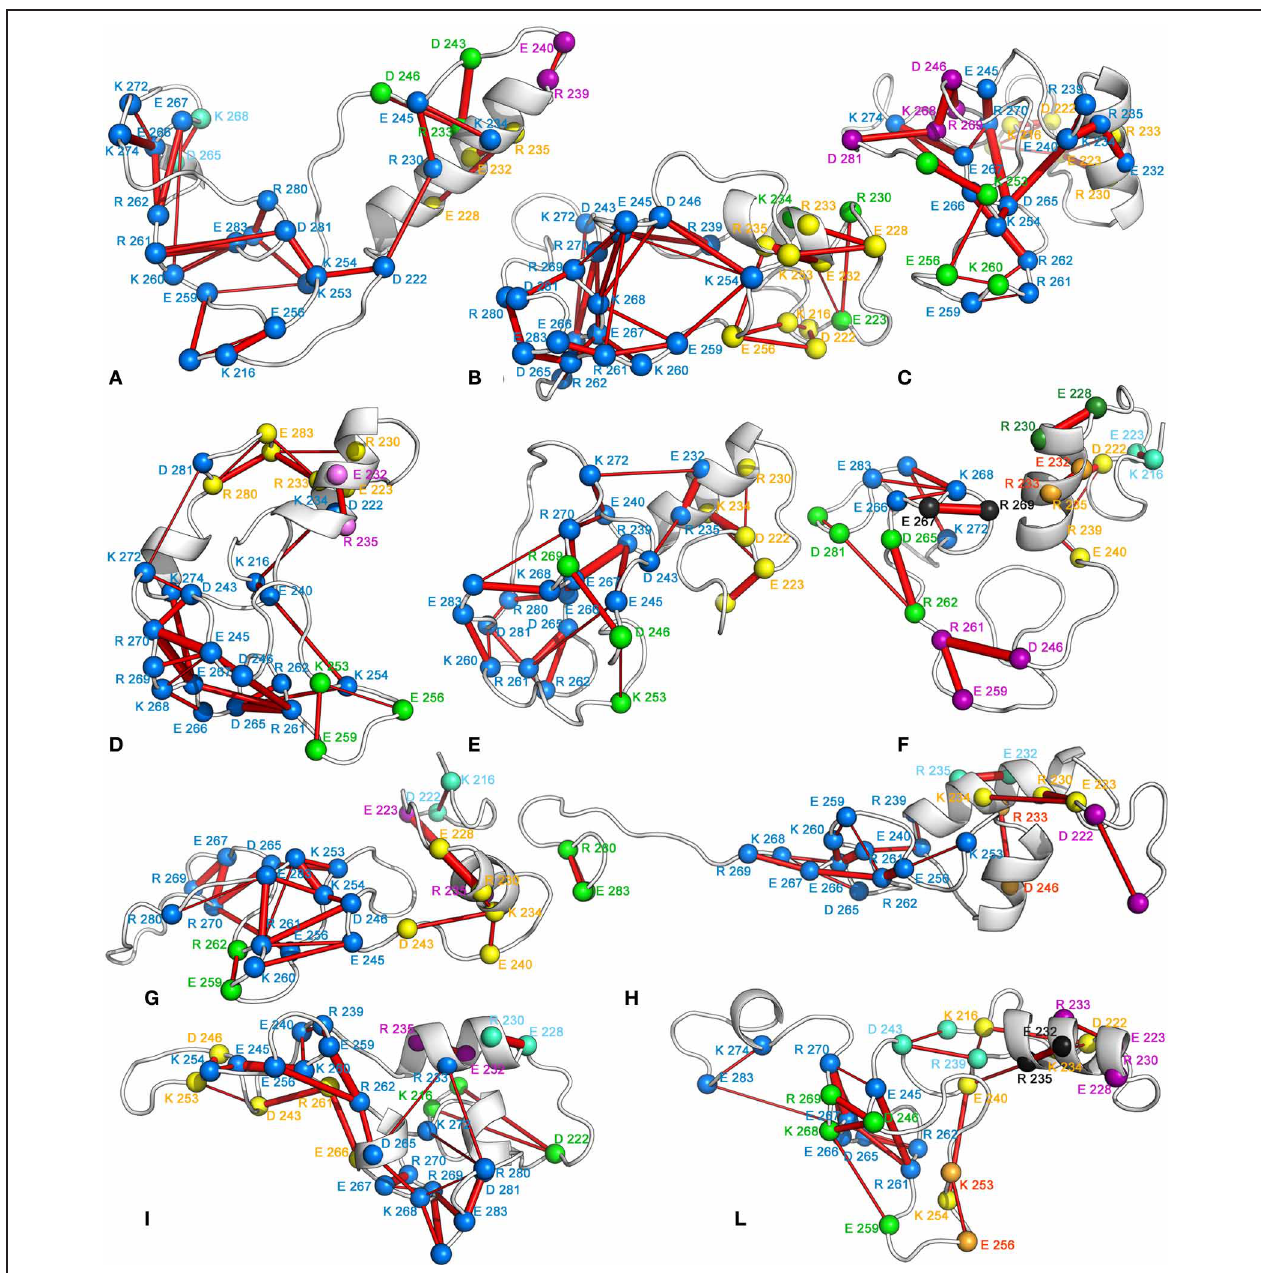
FIGURE 11 | Sub-networks of salt bridges. The 3D average structure of each FEL basin is shown as cartoon, and the C α atoms of the residues involved in salt bridges are shown as spheres. The C α atoms of the interacting residues are connected by sticks, whose thickness is proportional